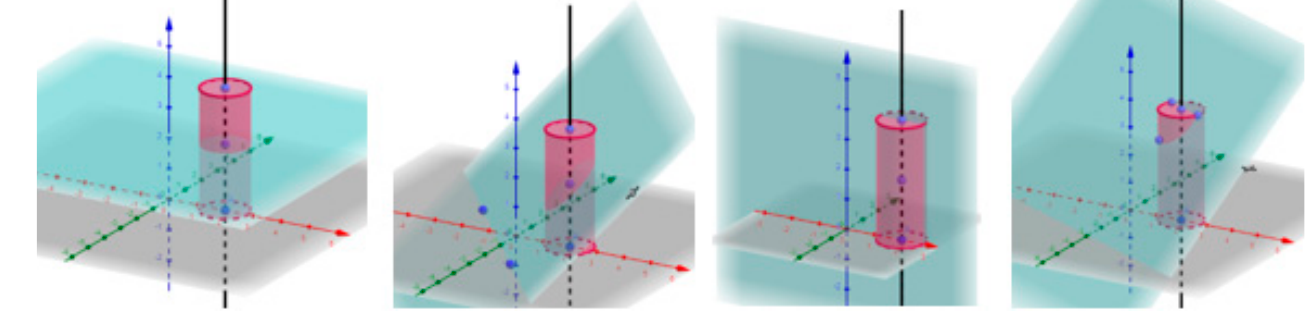
Figure 3. Shapes of the section figure produced in cylinders.